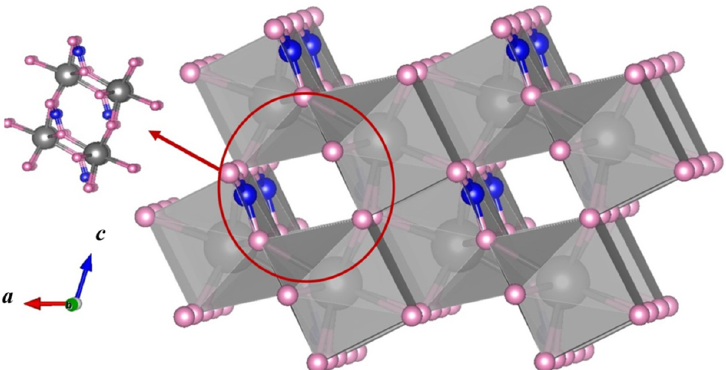
Figure 1. Monoclinic crystal structure of LaBO 3 along b -axis. LaO 9 is expressed as a gray nonahedron, and the B and O atoms are represented as blue and pink globules, respectively.